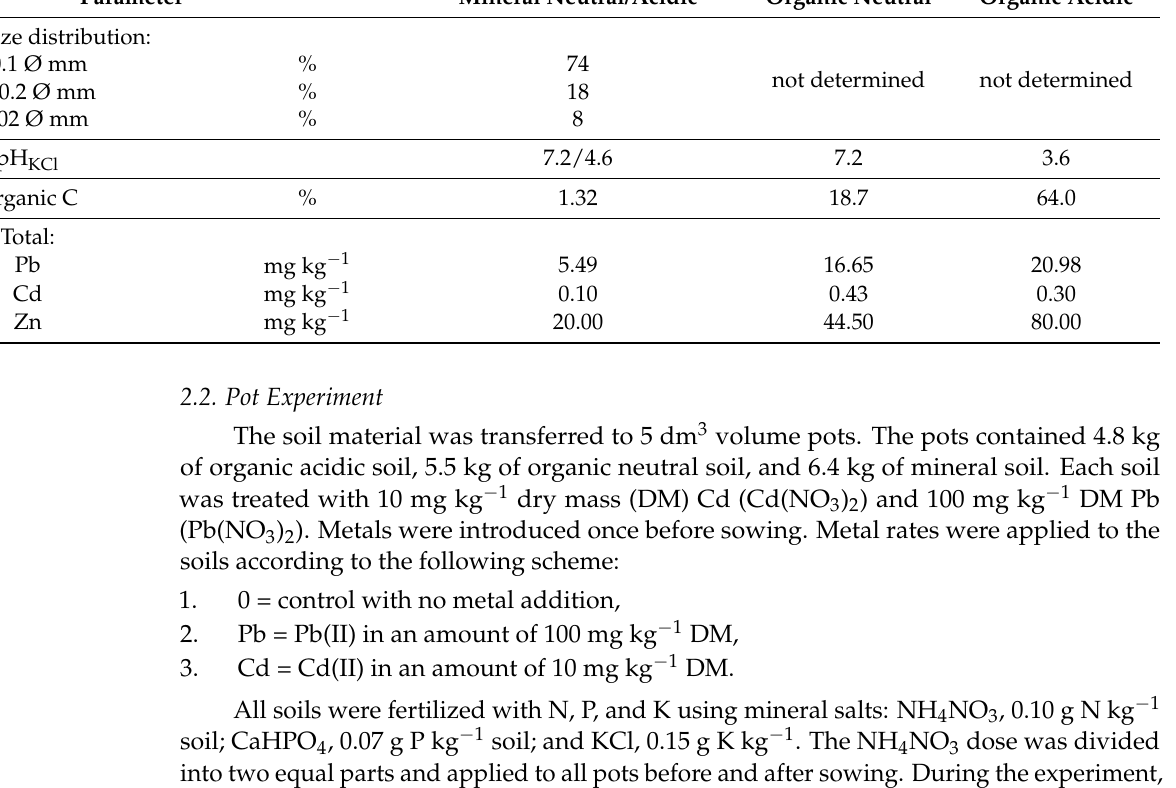
Table 1. Agrochemical characteristics of soils used for the experiment. Parameter Mineral Neutral/Acidic Organic